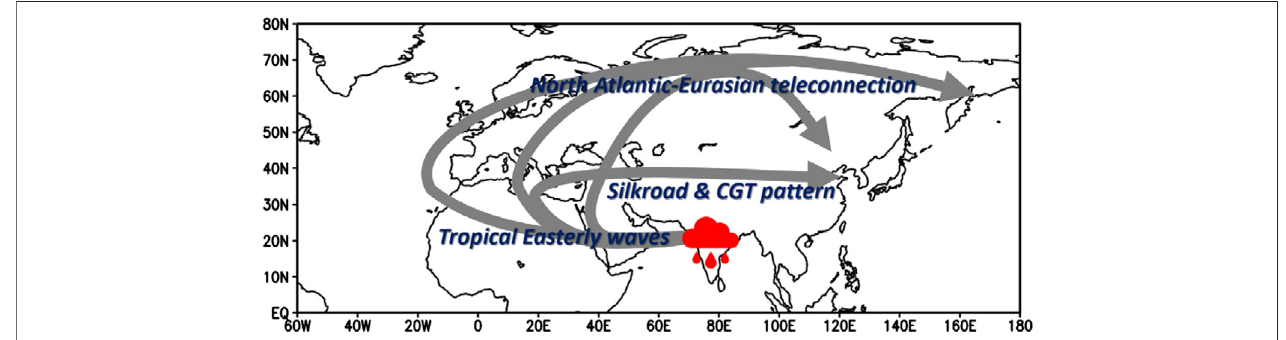
FIGURE 9 | Schematic diagram of the Northern Hemisphere teleconnection induced by the Indian monsoon. Gray lines show the teleconnection pathway generated from Indian diabatic heat forcing.